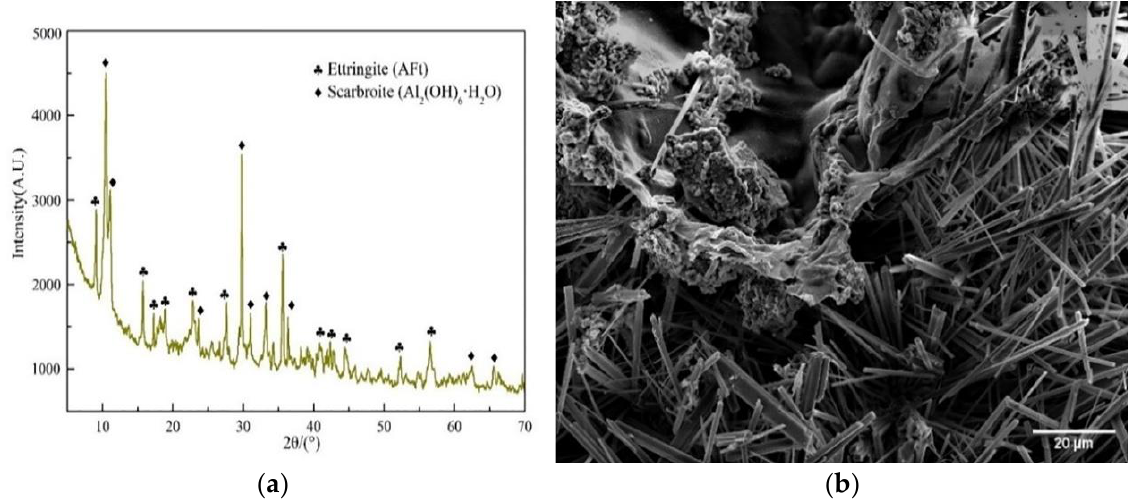
Figure 16. Micrograph of compressive strength of SCGPCS. ( a ) XRD diagram. ( b ) SEM.